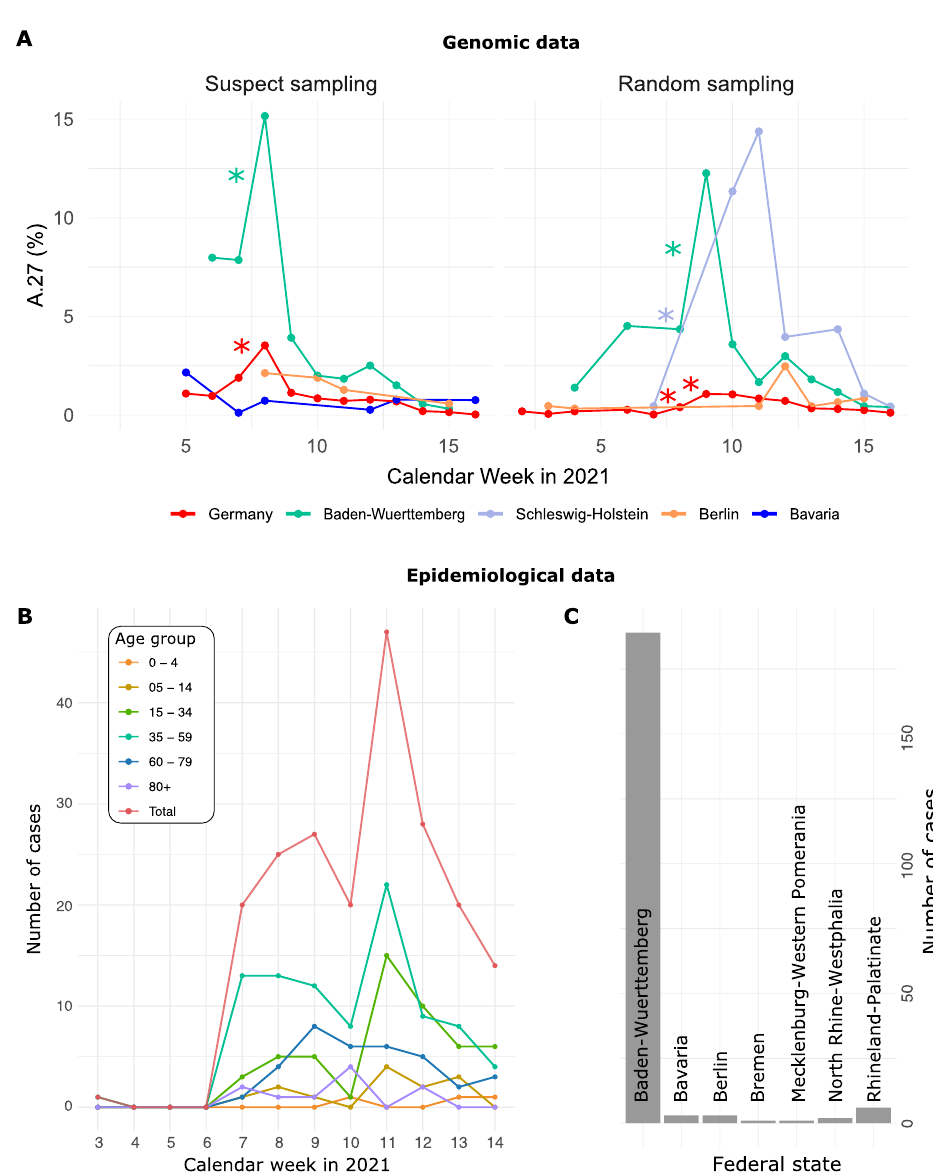
Figure 1. ( A ) Proportion of reported A.27 sequences compared between calendar weeks (CW) and based on suspect ( n = 271) and random sampling ( n = 206) strategies. Significant increases in proportion are marked with a star (adjusted p -value < 0.1). In CW 07–08, we observed a 2.1-fold increase in the proportion among suspect samples in the BW region and in CW 08–09 among random samples in the same region. Between CW07 and CW10 we observed an impressive 33-fold increase in proportion in Schleswig-Holstein among the random samples, however, no A.27 sequences were detected in CW08 and 09 for that region, and absolute numbers are low. ( B ) Epidemiological data of reported cases of lineage A.27 ( n = 205) in Germany per age group. Median age of cases was 45 years. Note that information was not available in the reporting system for all data points, so they may have no value. In general, no information was available for CW04–06 as of 30 April 2021. ( C ) Distribution of cases over federal states based on epidemiological data, 92% were notified in Baden-Wuerttemberg (date of reporting: 30 April 2021). Epidemiological data was not available for all federal